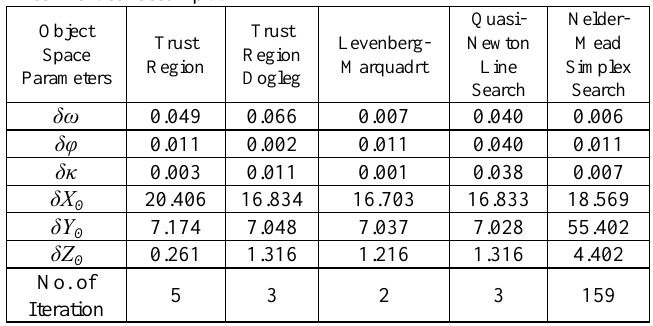
Table 3 Performance of nonlinear least squares methods with